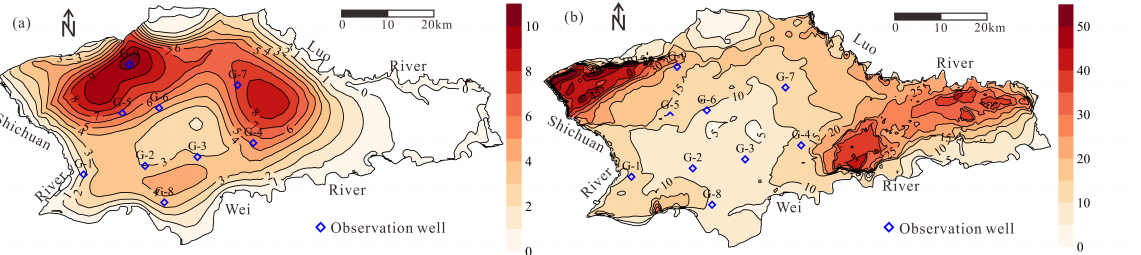
Figure 8. Maps showing the ( a ) decrease in water level and ( b ) buried depth after 50 years for scenario